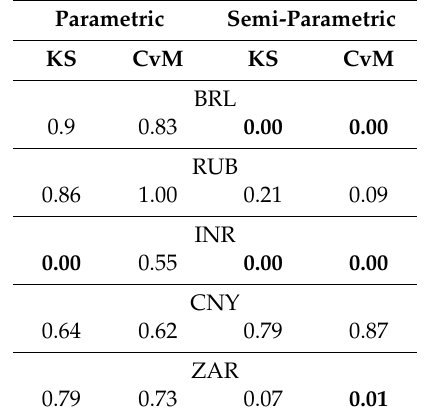
Table 14. Goodness-of-fit test for the time-varying copula models. Parametric